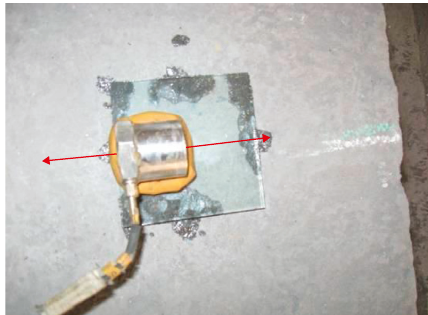
Figure 10: Acceleration transducer. The arrows indicate the direction of vibration which can be measured by acceleration transducer.